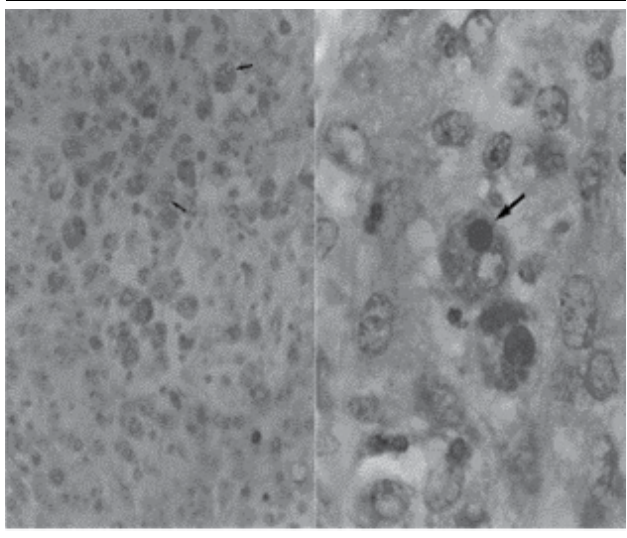
figurE 5 – Histiocytes with cytoplasmic positivity for CD68 antigen. Negative image, in the cytoplasm, corresponds to Michaelis-Gutmann bodies (Imunoperoxidase, 400×). In detail, von Hansemann histiocytes containing Michaelis-Gutmann bodies (PAS, 1000×) PAS: periodic acid-schiff.